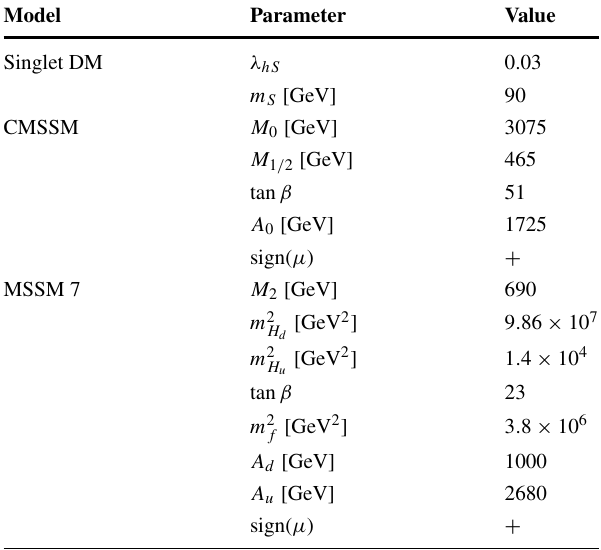
Table9 CentralpointsofspokesplottedinFig.6.Alloftheparameters of the MSSM 7 are defined at an energy scale of 1 TeV